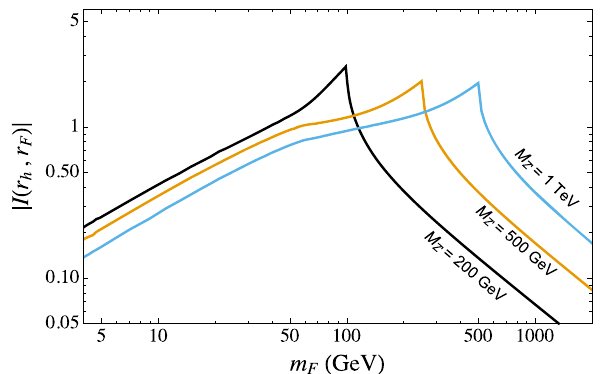
Fig. 5 The loop integral | I ( M h / M Z (cid:2) , m F / M Z (cid:2) ) | of Eq. (A.2) as a function of the fermion mass, for three values of M Z